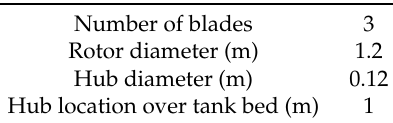
Table 1. Geometrical characteristic of the FloWave generic